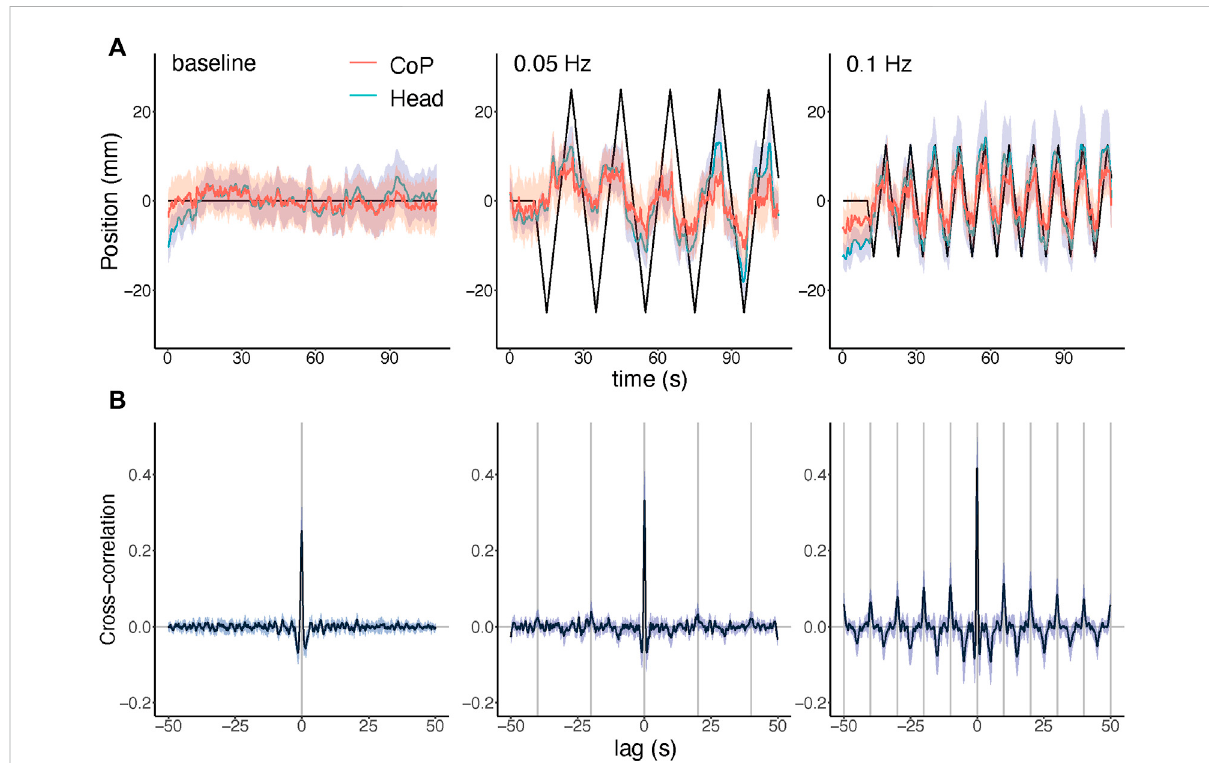
Results in the time domain. (A) Averaged CoP and head motion along the anterior-posterior (A – P) axis throughout the trial, for the baseline, 0.05 Hz change rate, and 0.1 Hz change rate conditions. Solid lines show simulated body motion by the optic fl ow. (B) Cross-correlations between head motion and CoP, each corresponding to the above time-series plot. Grey vertical lines indicate 0 lag and stimulus cycles for each condition. In all panels, shaded areas show 95% con fi dence